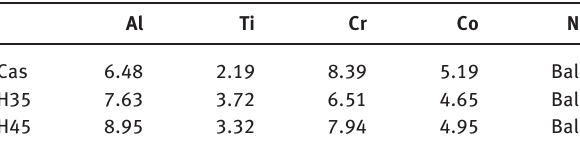
Table 4: The chemical composition (mass%) of γ ′ phase of non- HIPed and HIPed